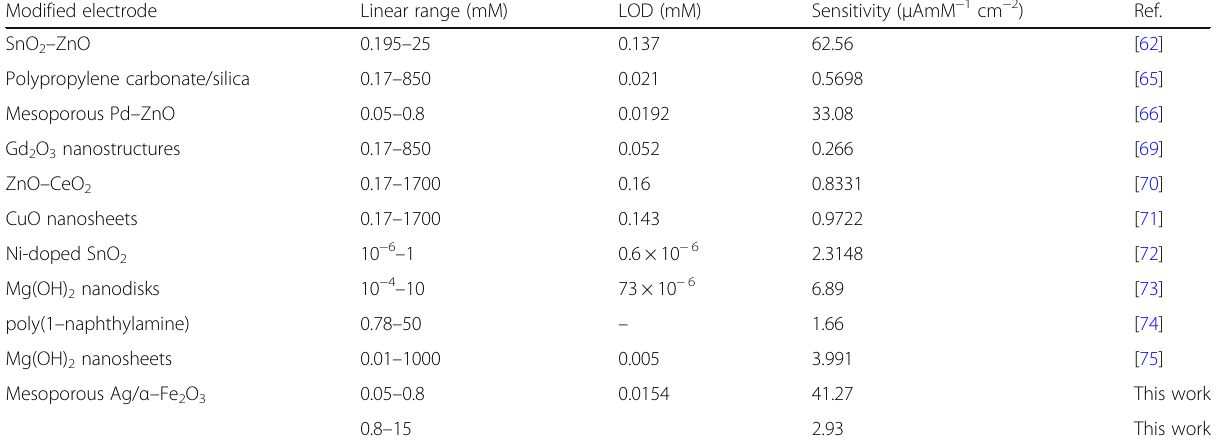
Table 2 Comparison of sensing performance of ethanol with previously reported modified electrodes Modified